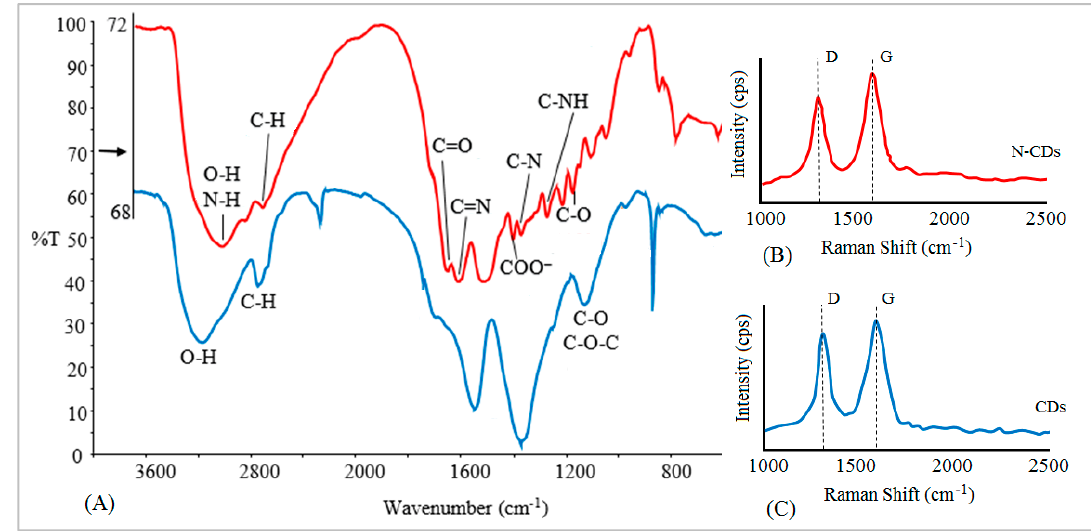
Figure 1. ( A ) Fourier transform-infrared (FT-IR) spectra of (red) nitrogen functionalized carbon dots (N-CDs) and (blue) nonfunctionalized carbon dots (CDs). ( B ) Raman spectra of N-CDs. ( C ) Raman spectra of CDs.